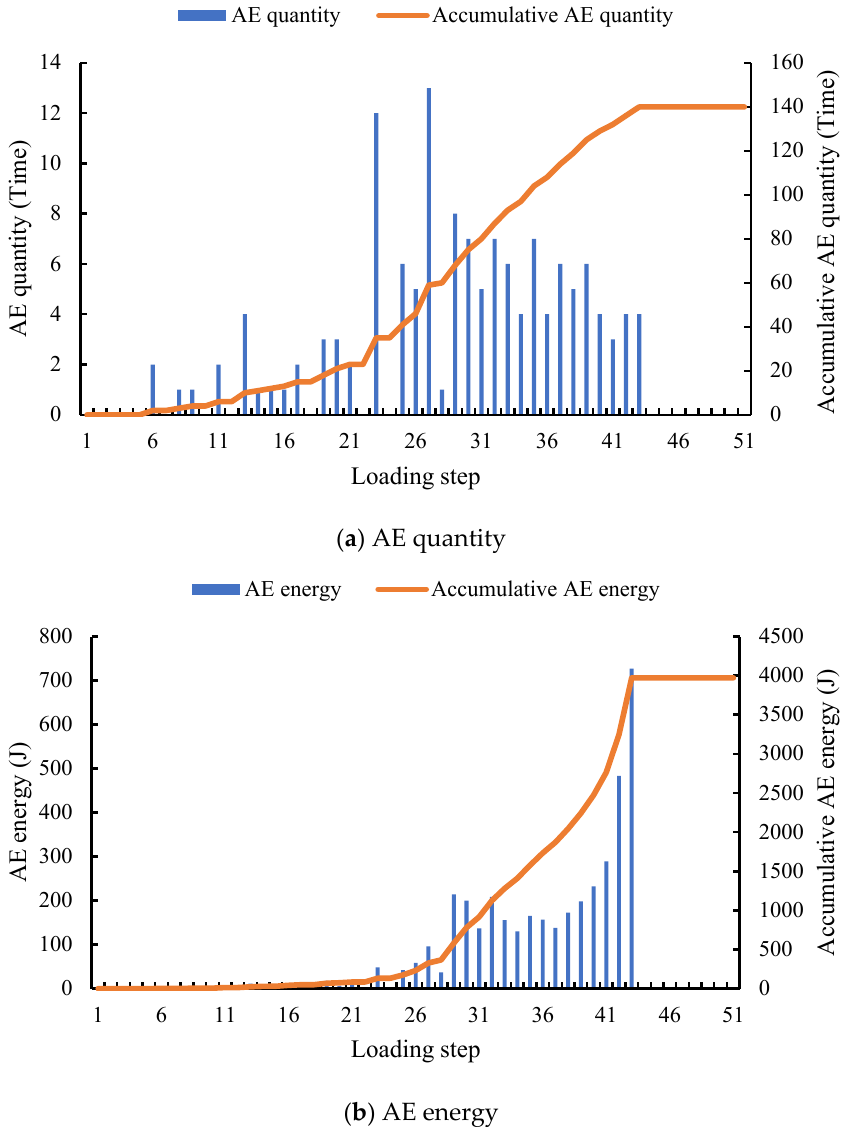
Figure 25. Acoustic emission variation trend of specimens with concrete contact surface. As shown in Figure 26, when the contact surface is geotextile, the AE quantity is distributed discretely during the entire loading process, the AE quantity both reached the maximum value of 8 at the 10th and 21st loading steps, and the accumulative AE quantity after the end of the loading is 119. The AE energy reached the maximum value of 647 J in the last loading step. The accumulative AE energy after loading is